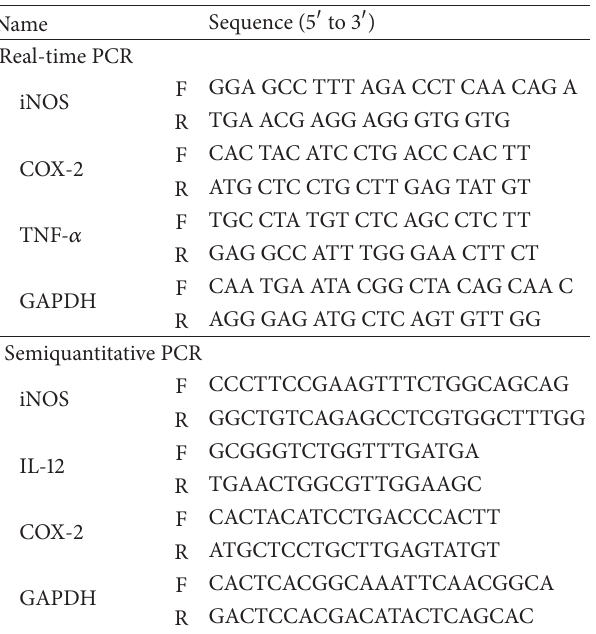
Table 1: Primer sequences used in RT-PCR